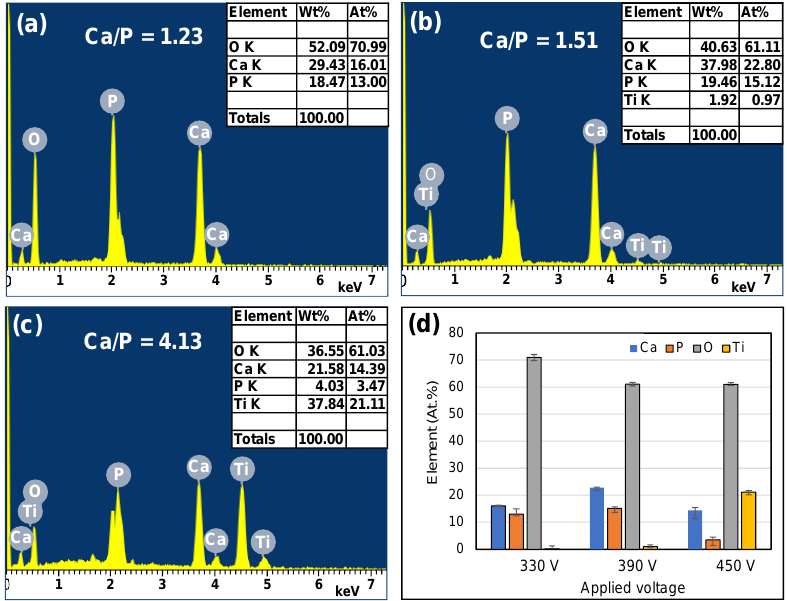
Figure 9. EDS spectra at accelerating voltage of 15 kV for ( a ) 330 V, ( b ) 390 V, and ( c ) 450 V coatings. ( d ) Average chemical compositions of ( a – c ) (applied current: 0.6 A, duration time: 5 min).